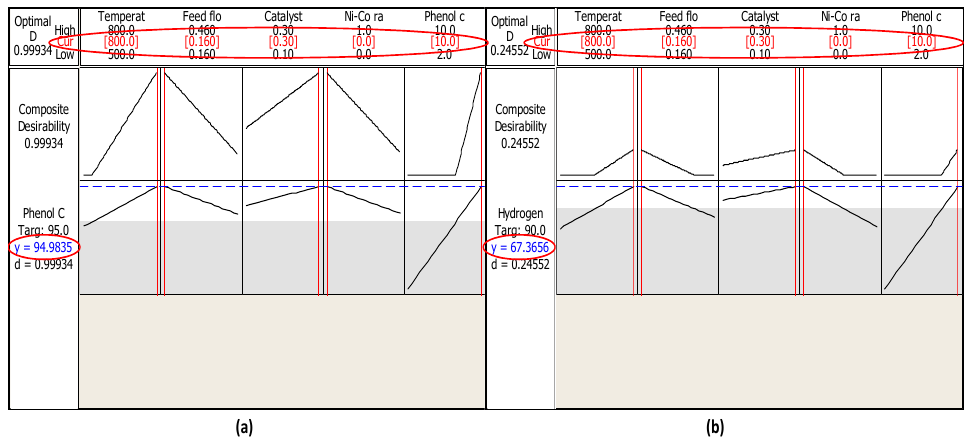
Figure 15. Results from the Response Optimizer tool for Y 1 ( a ) and Y 2 ( b ).